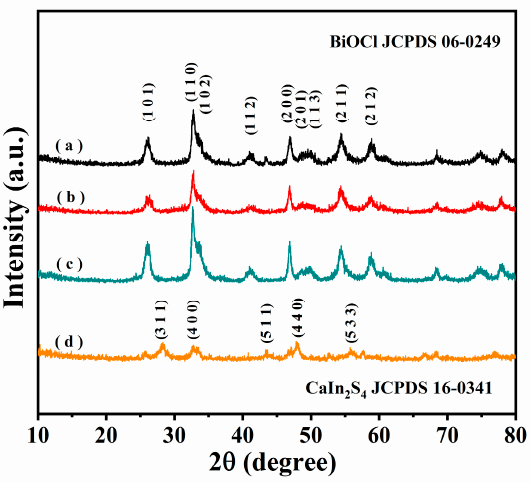
Figure 1. XRD patterns of ( a ) pure BiOCl, ( b ) BOC-SOVs, ( c ) 1% CIS/BOC-SOVs, and ( d ) pure CaIn 2 S 4 .